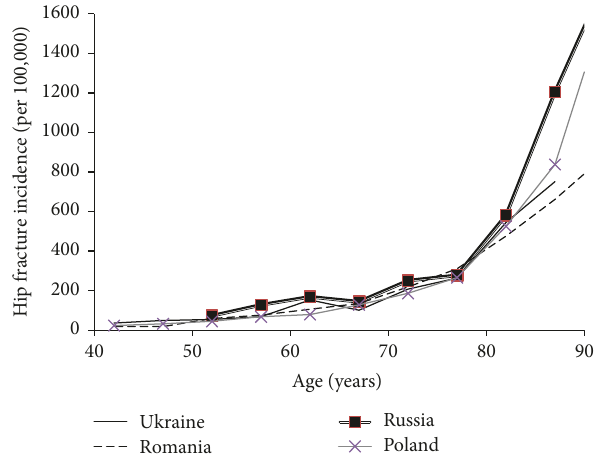
Figure 4: Hip fracture incidence by age in women within Ukraine and in the neighboring countries of Russia, Poland, and